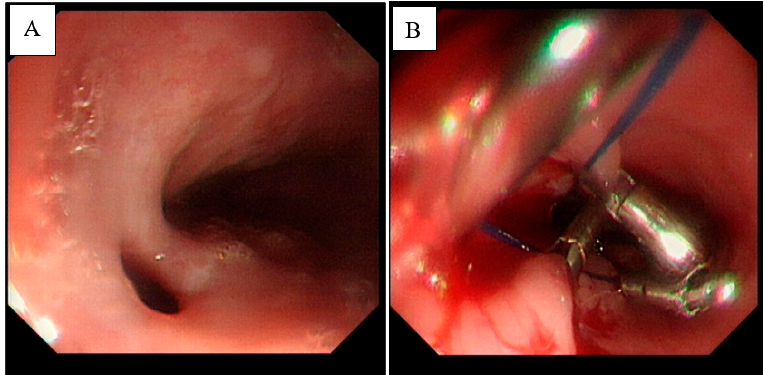
Figure 4. The chest CT examination of the patients before admission showed the formation of an esopha-geal mediastinal fistula. The inflammatory indicators increased, indicating the possibility of oe-sophagus mediastinal fistula infection. Next, by inducing fasting conditions, we reduced the risk of infection. After the patient’s infection was controlled, and the endoscopy was perfected, we found that there was a fistula about 4 × 4 mm in the middle of the patient’s oesophagus ( A ). According to the results of the gastroscopy, the esophageal mediastinal fistula was treated by clamping the esophageal mediastinal fistula with a titanium clip under the endoscope ( B ).